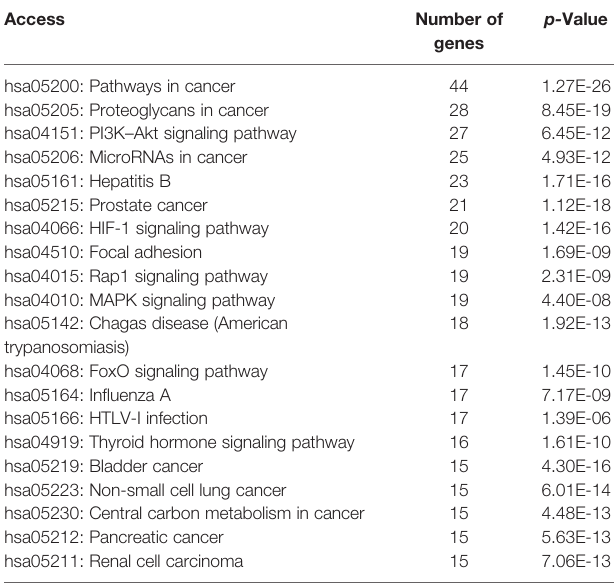
TABLE 3 | KEGG analysis of top 20